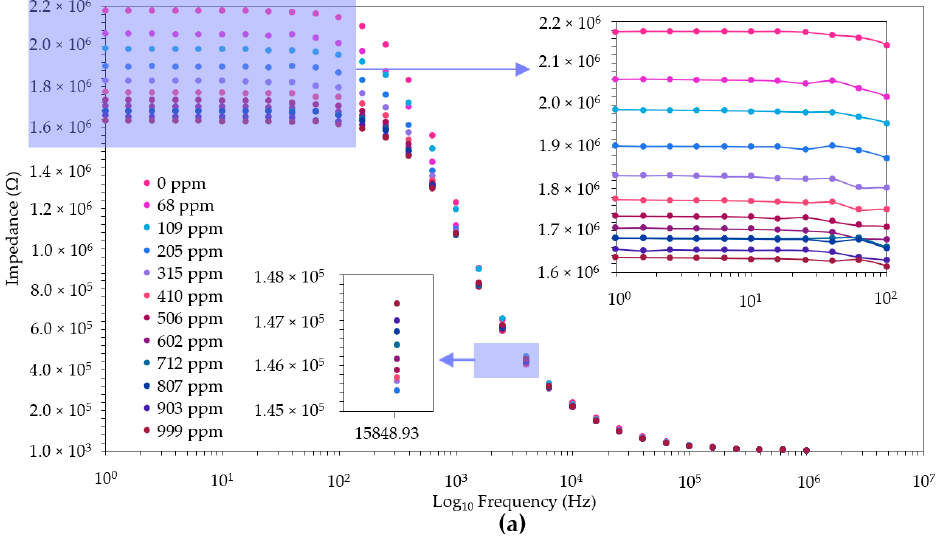
Figure 4. Impedance spectra of the ZnO (100% O 2 )-based film sensor obtained for eucalyptol ( a ) and α -pinene ( b ), and normalized impedance ( Ω ) spectra at a fixed frequencies (eucalyptol, 15,848.93 Hz; α -pinene, 3.98 Hz, ( c ) for the measurement of different concentrations in air. The average and standard deviations of the respective impedance data of the duplicates were used for the normalization (Supplementary Materials, Tables S6 and S14). Similarly, at the fixed frequencies of 15,848.93 Hz (eucalyptol) and 3.98 Hz ( α - pinene), these thin films exhibited a high linearity ( r ≥ 0.92) in the quantification of eucalyptol and α -pinene, respectively, as can be observed in Figure 4c. Furthermore, as expected according to the discrimination observed in Figure 4b, in the lower frequencies, the thin films showed good repeatability (RSD ≤ 14.4%) for the α -pinene assessment at 3.98 Hz. However, this was not verified for the eucalyptol, where a greater repeatability (RSD ≤ 13.9%) was obtained at higher frequencies (e.g., 15,848.93 Hz), where the capacity for concentration discrimination was not as strong as that seen in the frequency range of 1 to 100 Hz (Figure 4a). 3.2. Principal Component Analysis Following the analysis of the electrical responses and capabilities of the nanostructured thin-film-based sensors, the electronic nose concept was evaluated. Using